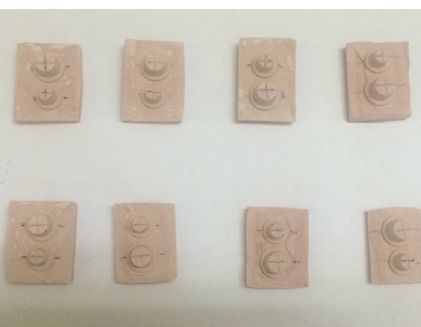
Figure 4: Stone dies obtained from impression.